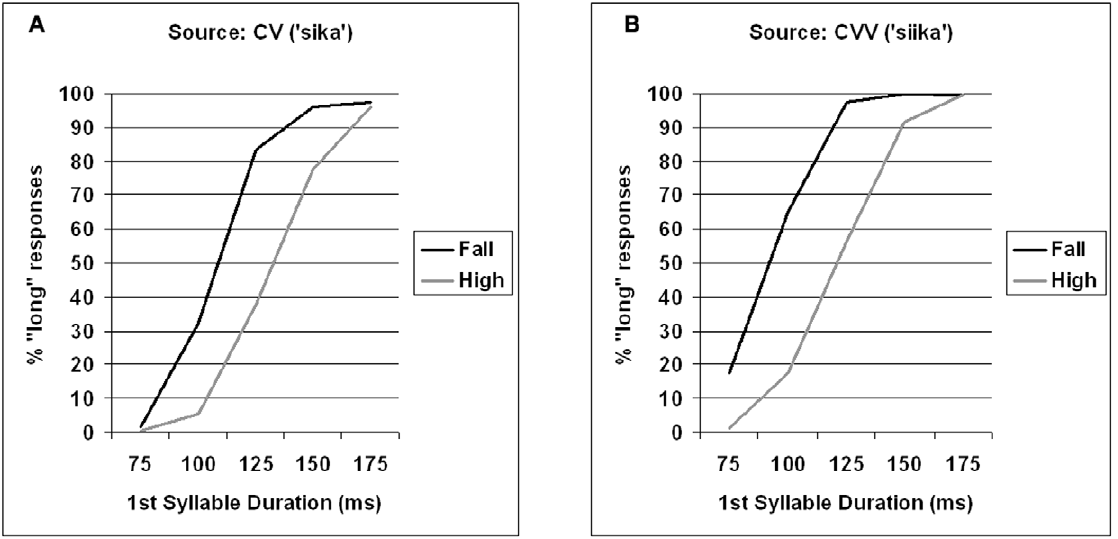
Figure 1. Effects of first syllable duration and Tone in Experiment 1. Effects of first syllable duration (75–175 ms) and type of tone (high, fall) in Experiment1 for source words with short (panel A) and long (panel B) syllables. doi:10.1371/journal.pone.0012603.g001 PLoS ONE |